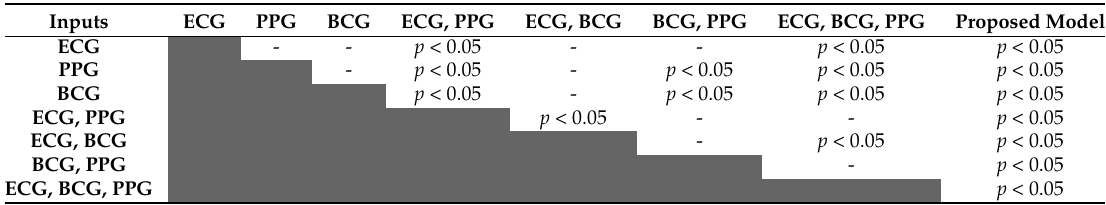
Table 5. Results of paired t -test between various inputs for SBP estimation.